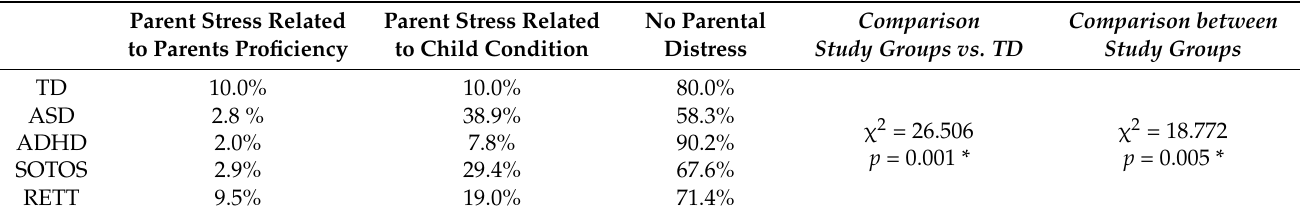
Table 3. Parent stress: Parents’ Proficiency vs. Child